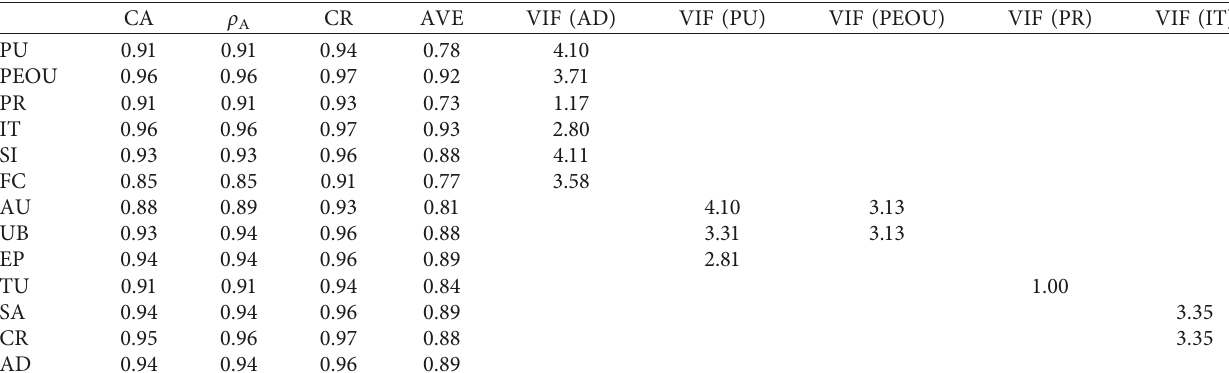
Table 5: CA, ρ A , CR, AVE, and VIF.